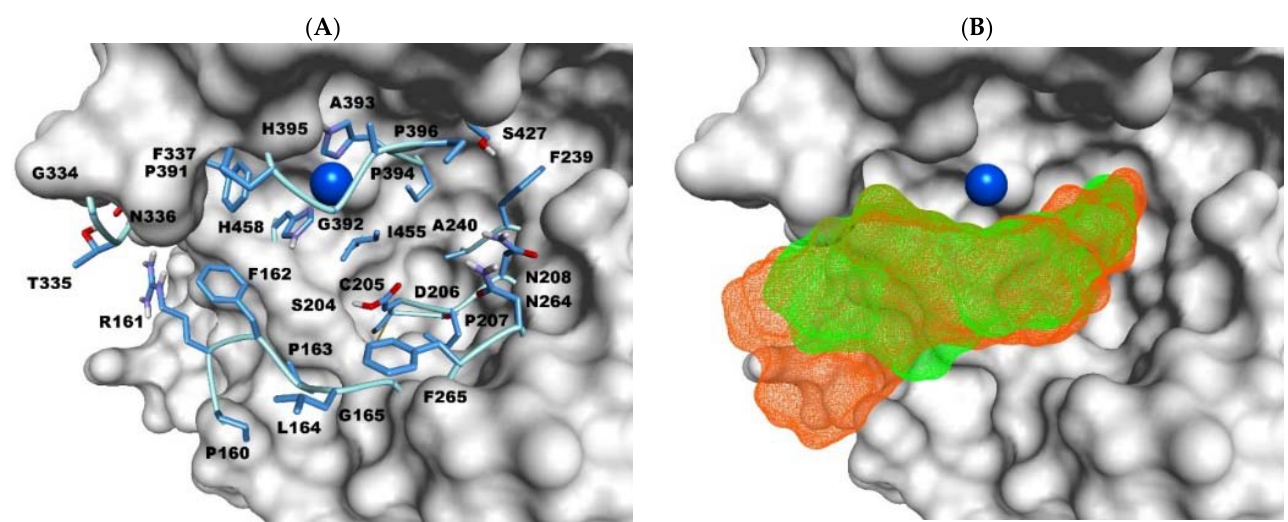
Figure 8. The active center of the laccase (PDB: 1GYC) with selected amino acids building the cavity ( A ) and the position of investigated inhibitors shown as grids ( B ). The sidechains of amino acids are shown as blue sticks and the protein is shown as a light blue tube and its surface is colored gray. The Cu ion is shown as a blue sphere. The mesh of the competitive inhibitors is green, uncompetitive, non ‐ competitive, and mixed is orange.